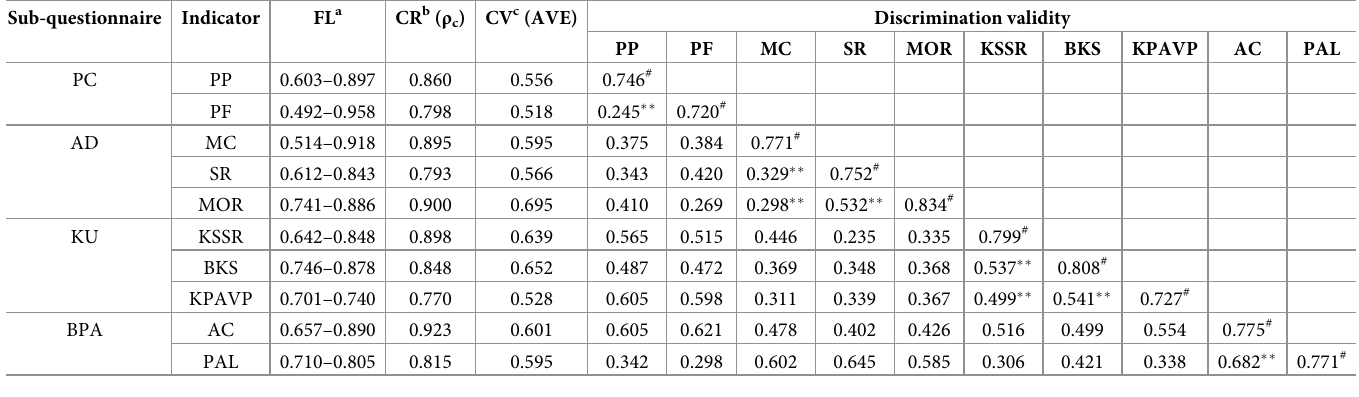
Table 12. Composite reliability, convergent validity and discrimination validity index of the first-order model fit of PLAQ. Sub-questionnaire Indicator